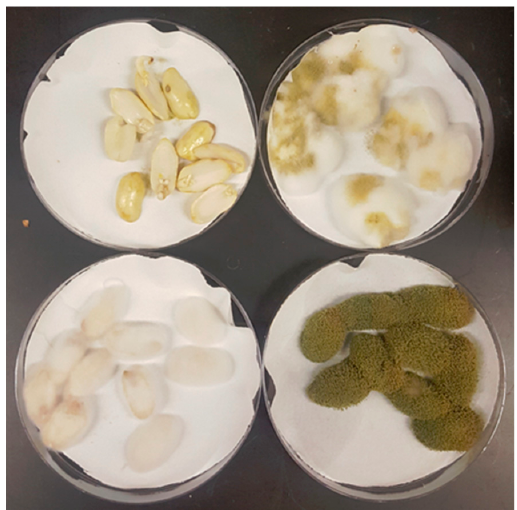
Figure 3. Growth of three A. flavus strains on raw peanuts. After four days, growths of NRRL 35739 on the hosts were less thick than the fluffy or heavily sporulating growths of aflatoxigenic strains NRRL 3357 and NRRL 6513. Clockwise from the top left: negative control, NRRL 3357, NRRL 6513, and NRRL 35739. The image is representative of three replicates.